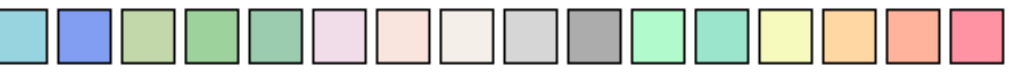
Figure 5. The OpenStreetMap color scheme.